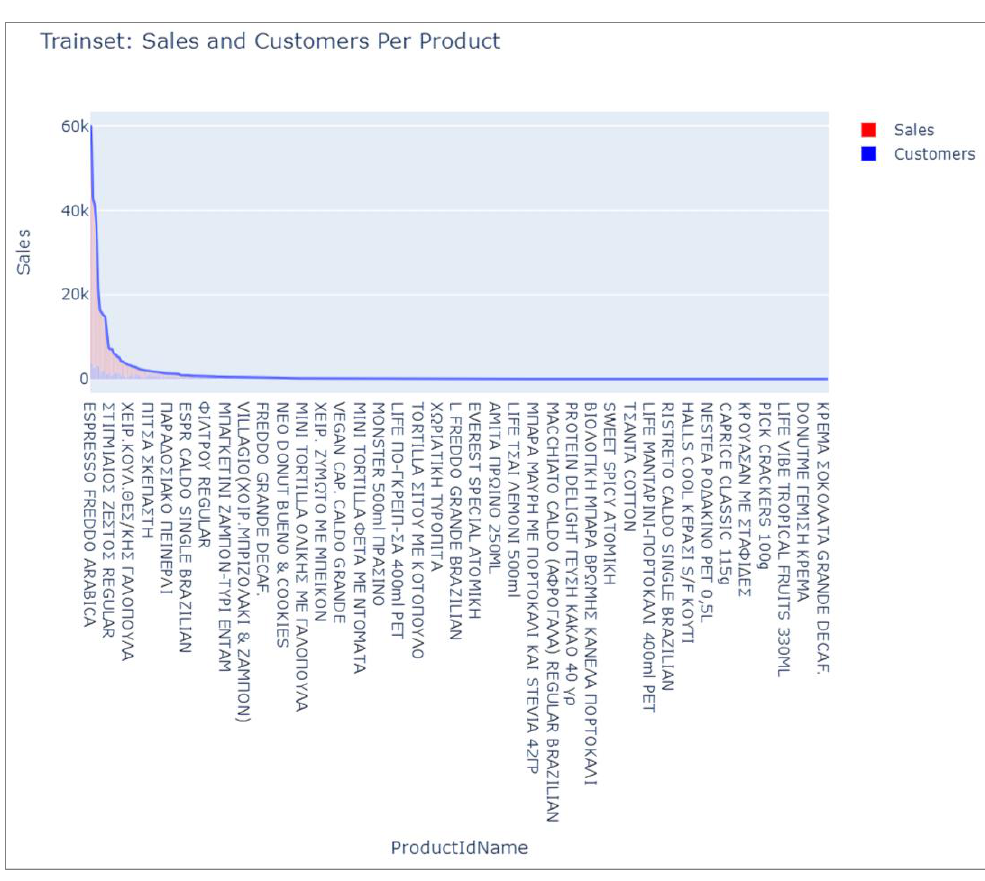
Figure 10. Long Tail (sales per